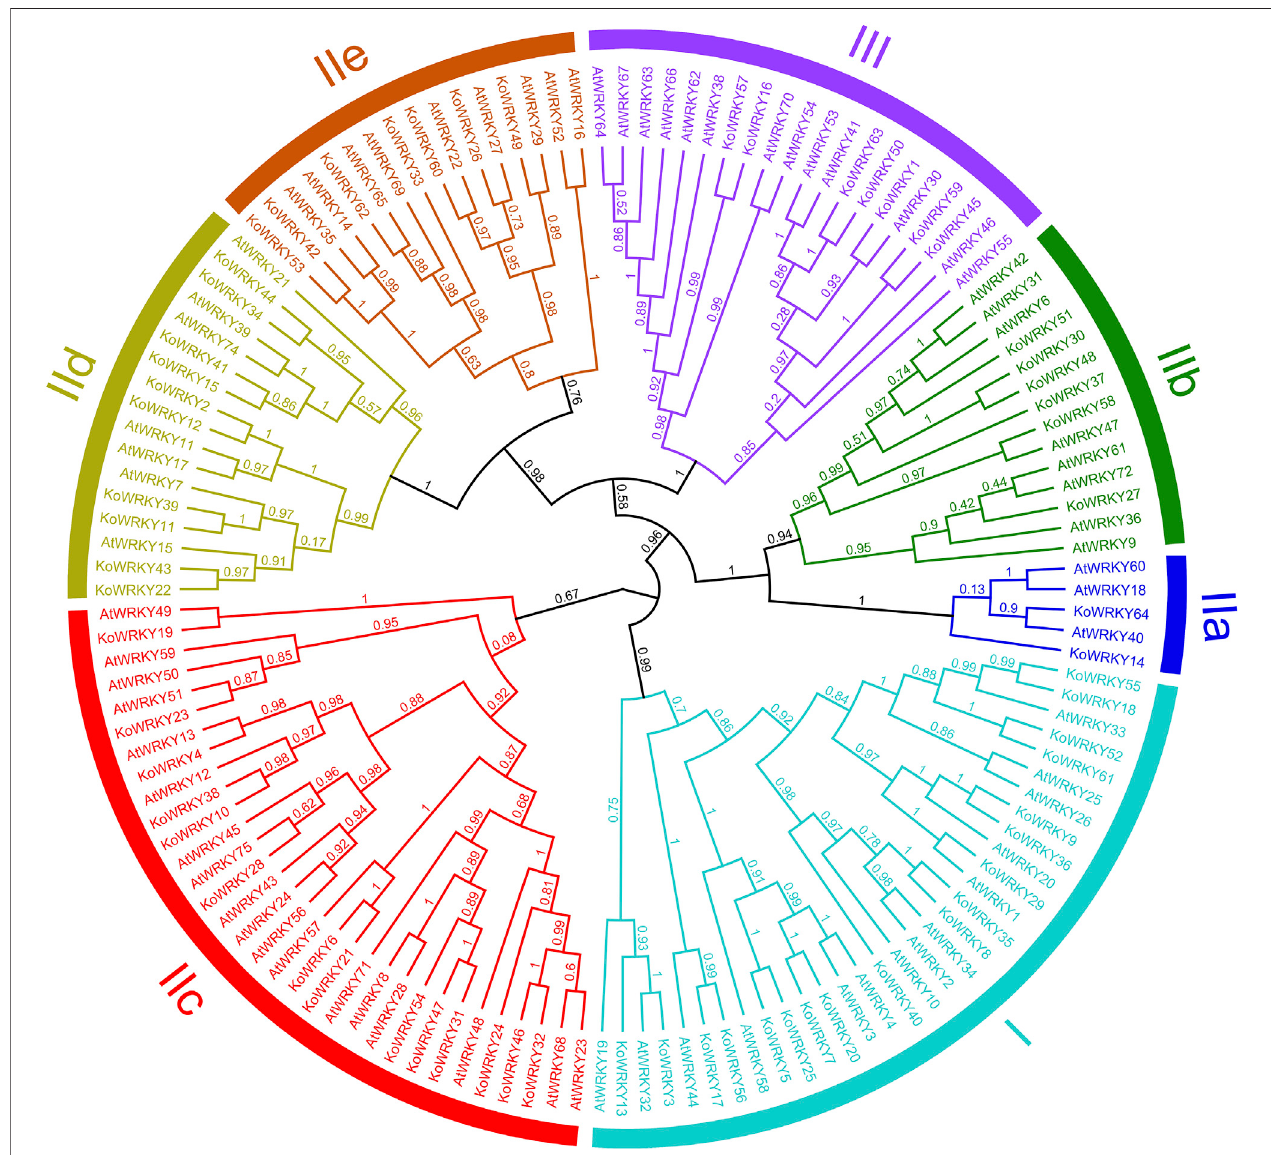
FIGURE 5 | Phylogenetic relationships among WRKYs identi fi ed in Kandelia obovata and Arabidopsis thaliana . In total, 64 KoWRKY and 72 AtWRKY protein sequenceswereusedtoconstructthephylogenetictreeusingMEGA7and maximum likelihood(ML)method analysis(1,000replicates).The K.obovata and A.thaliana genes are indicated at the ends of the branches. Subgroups I, IIa, IIb, IIc, IId, IIe, and III were named according to the results for A. thaliana . The colored regions indicate different subfamilies.